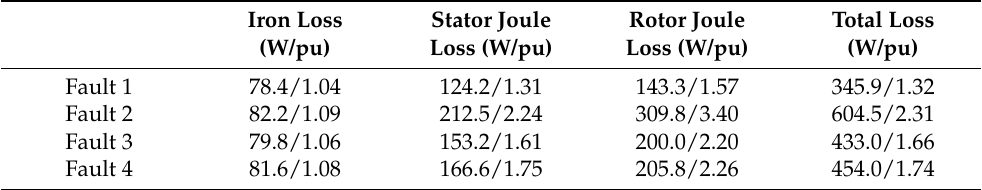
Table 4. Loss distribution for fault conditions under 20 Nm